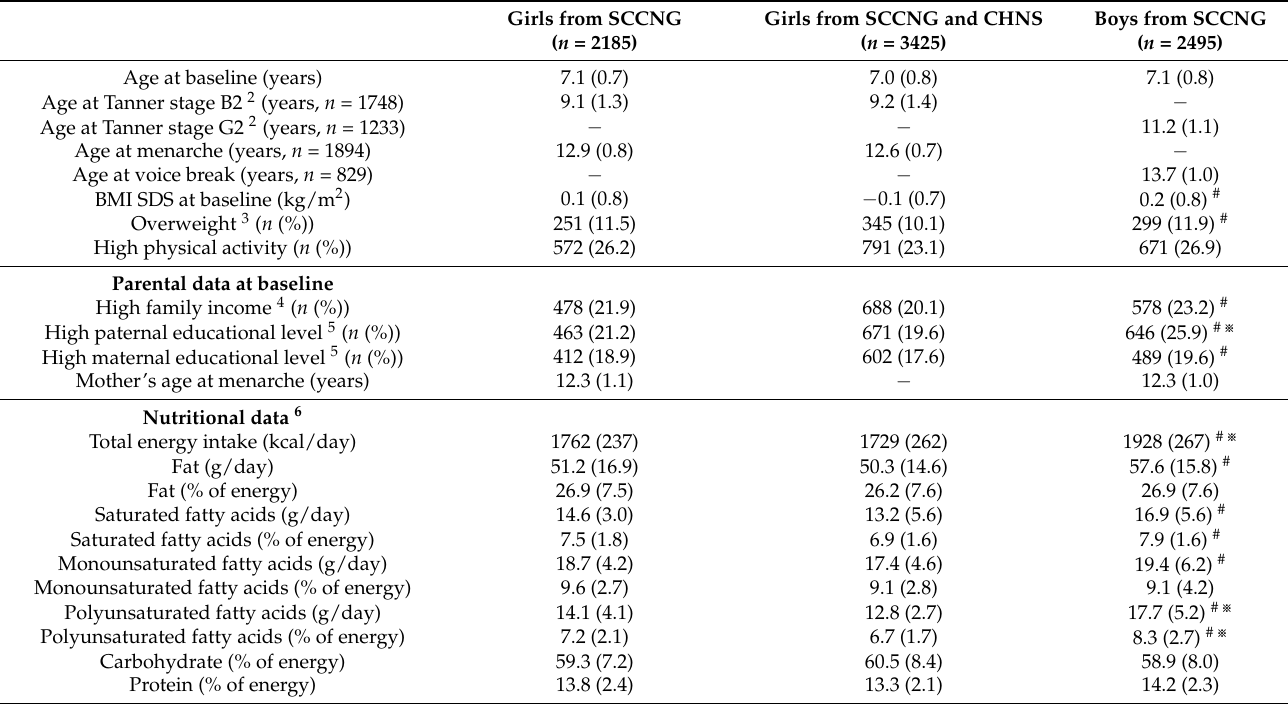
Table 1. Characteristics 1 of participants in our